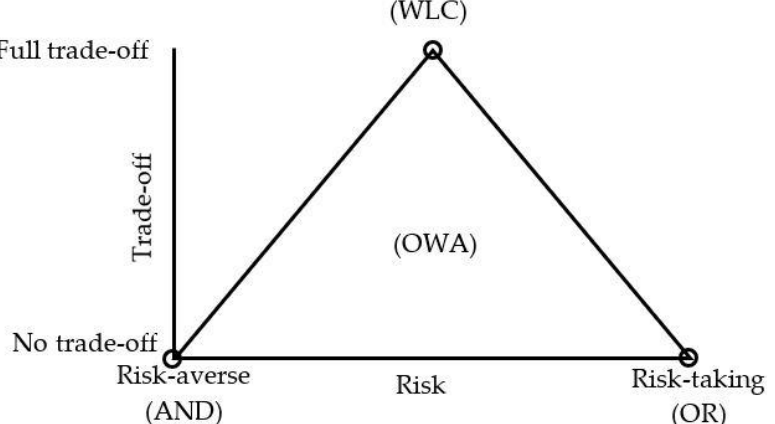
Figure 3. Decision strategy triangle within the continuum of risk and trade-off dimension, adapted from Eastman [56].